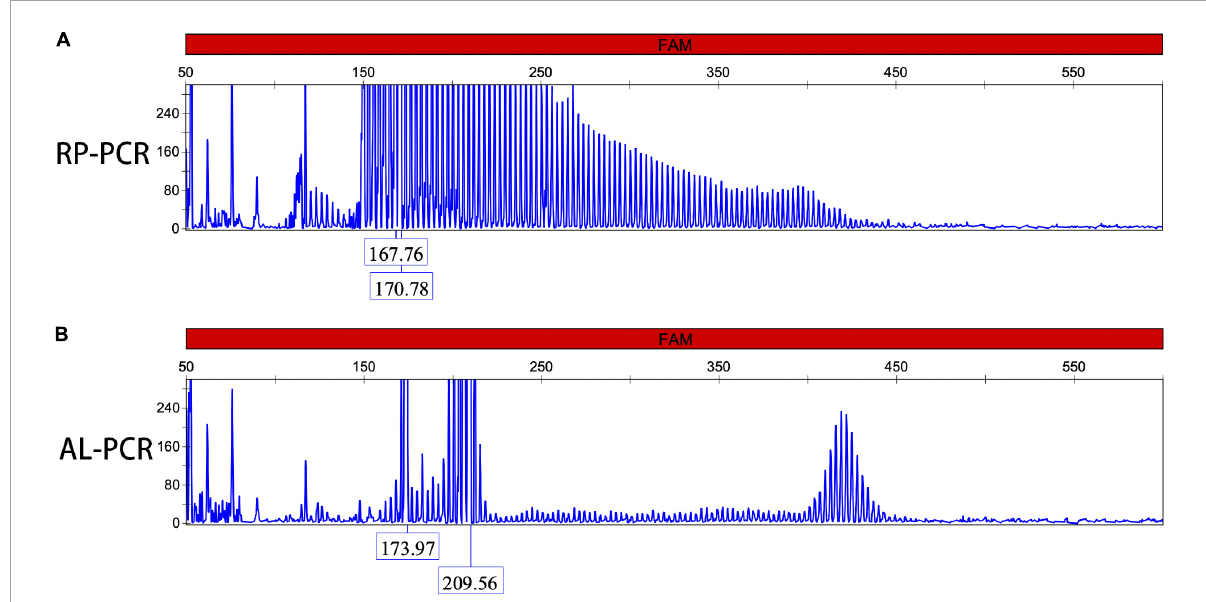
FIGURE2 Dynamic variant of the NOTCH2NLC gene. Repeat-primed polymerase chain reaction (RP-PCR) chromatogram of patients 1 showed a long saw-tooth curve, indicating the presence of CGG repeat expansion (A) ; Amplicon length polymerase chain reaction (AL-PCR) showed that the number of CGG repeat was 102 (B) .